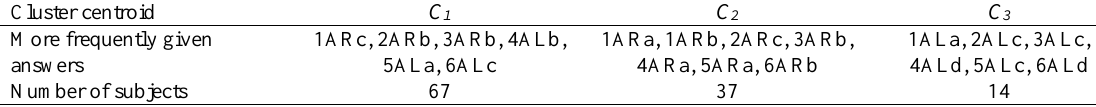
Table 2 An overview of results obtained by k-means method Cluster centroid C 1 C 2 More frequently